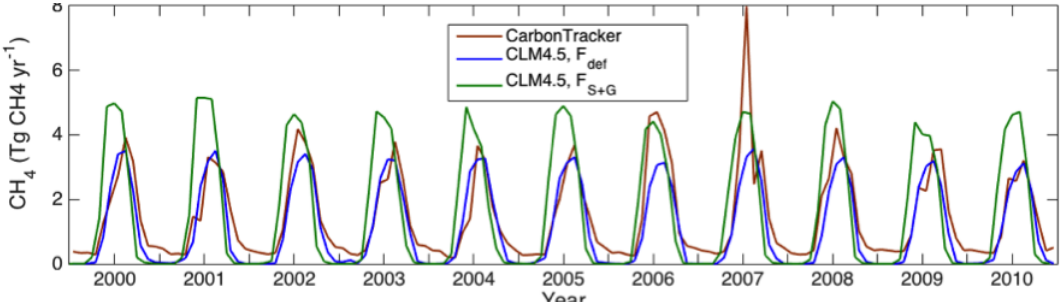
Figure 6. Time variation of integrated CH 4 (TgCH 4 yr − 1 ) emissions from Alaska by CarbonTracker (brown), CLM4.5 with internally predicted fraction of inundation F def (blue) and CLM4.5 SWAMPS-GLWD fraction of inundation F S+G (green).